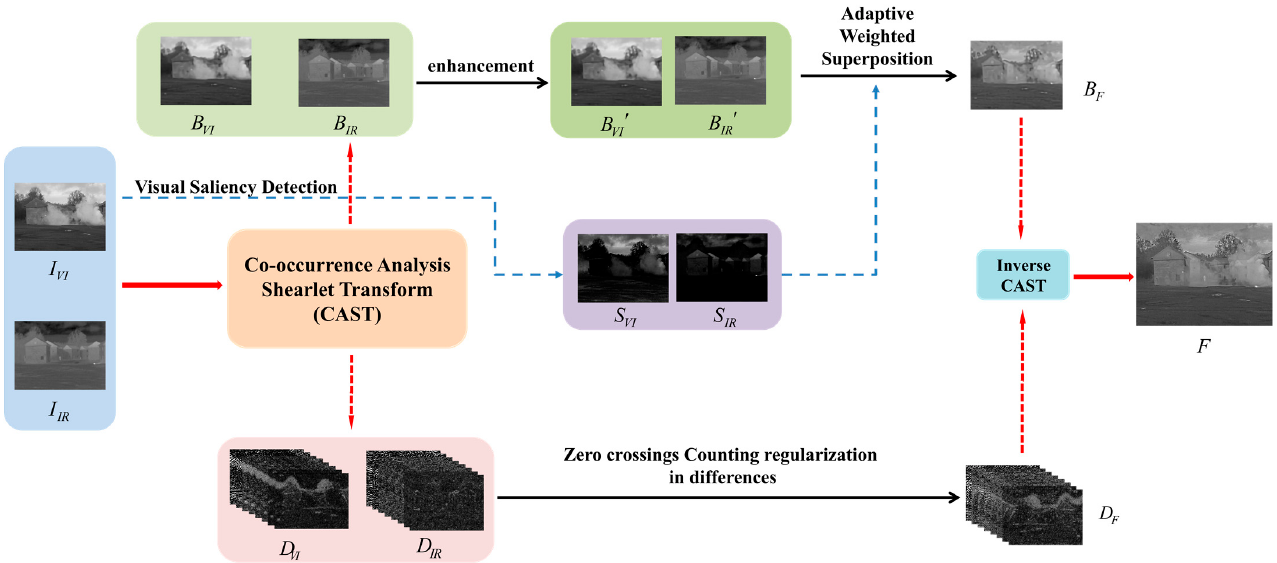
Figure 4. Image fusion framework based on the proposed method.